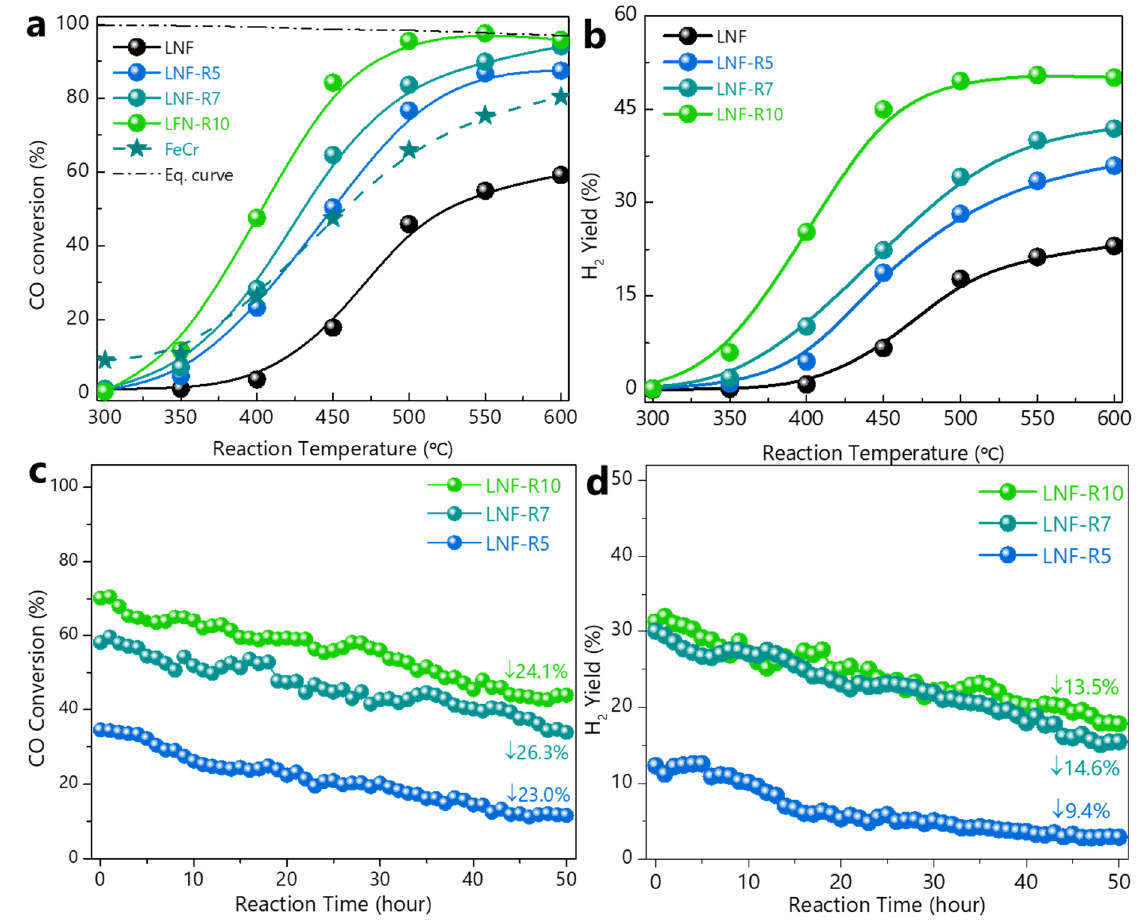
Figure 5. WGS activity for LNF samples with different exsolution treatment times. ( a ) CO conversion for WGS; ( b ) H 2 yield for WGS; long-term stability of ( c ) CO conversion; ( d ) H 2 yield comparison. Reaction conditions: 30 mg of catalyst, 100 sccm of total flow (1 sccm CO and 23 sccm H 2 O vapor balanced with Ar) at GHSV = 146,000 mL/(h·g cat ). Long-term stability reaction conditions: GHSV = 146,000 mL/(h·g cat ) at 500 °C for 50 h. Table 2. Catalytic activity and stability of the reduction treated LNF samples.